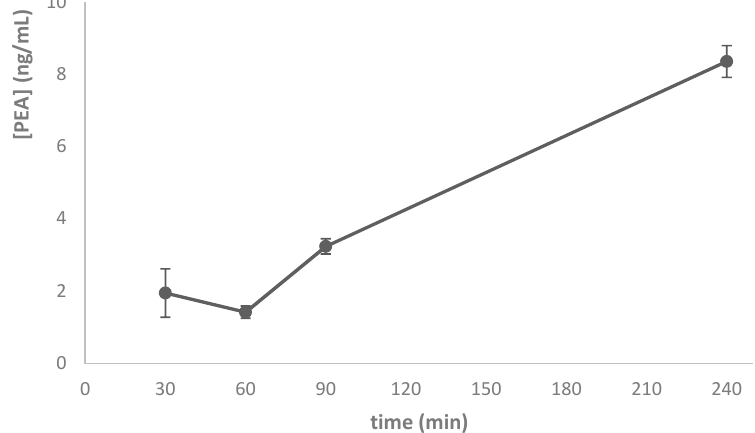
Figure 5. Retinal PEA distribution after instillation of a single dose of PEA-NLC formulation.